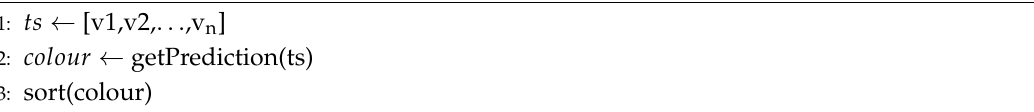
Algorithm 2 Flexible program using ML prediction.